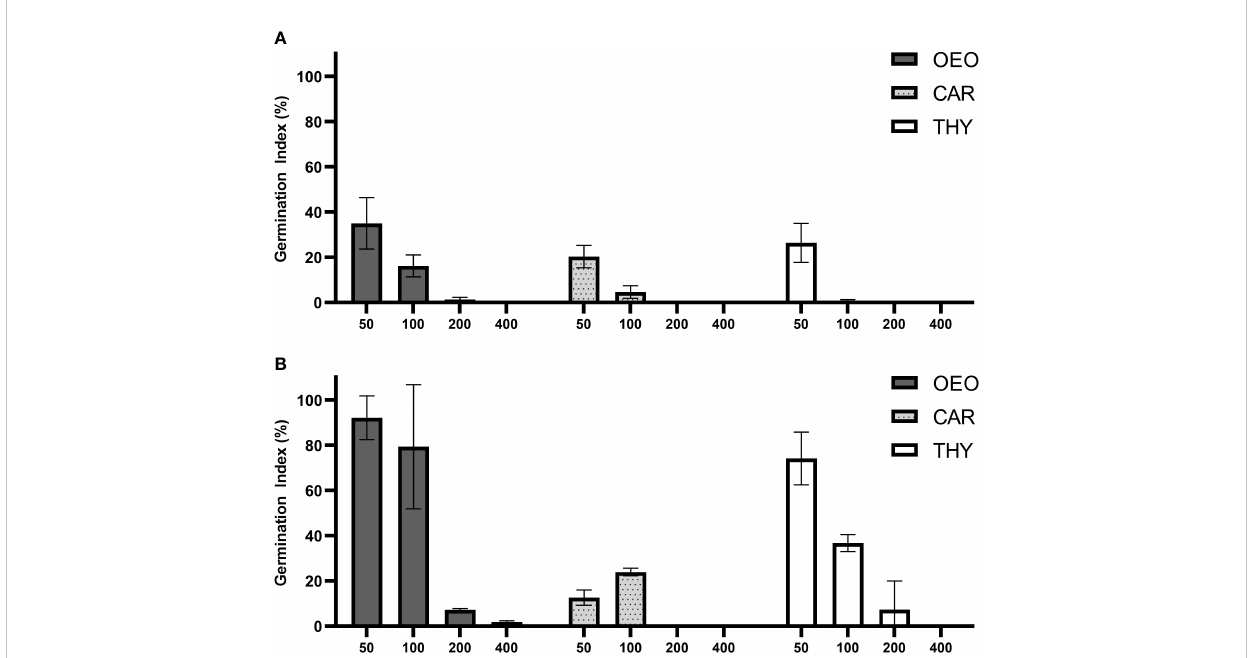
FIGURE 6 OEO, THY and CAR exhibited phytotoxic effect against seeds of Lactuca sativa and Solanum lycopersicum . Graph of Germination Index (%) of (A) Lactuca sativa and (B) Solanum lycopersicum when exposed to various concentrations of Oregano essential oil (OEO), carvacrol (CAR) and thymol (THY) (400; 200; 100; 50 µg.mL -1 ). Error bars depict standard deviation between